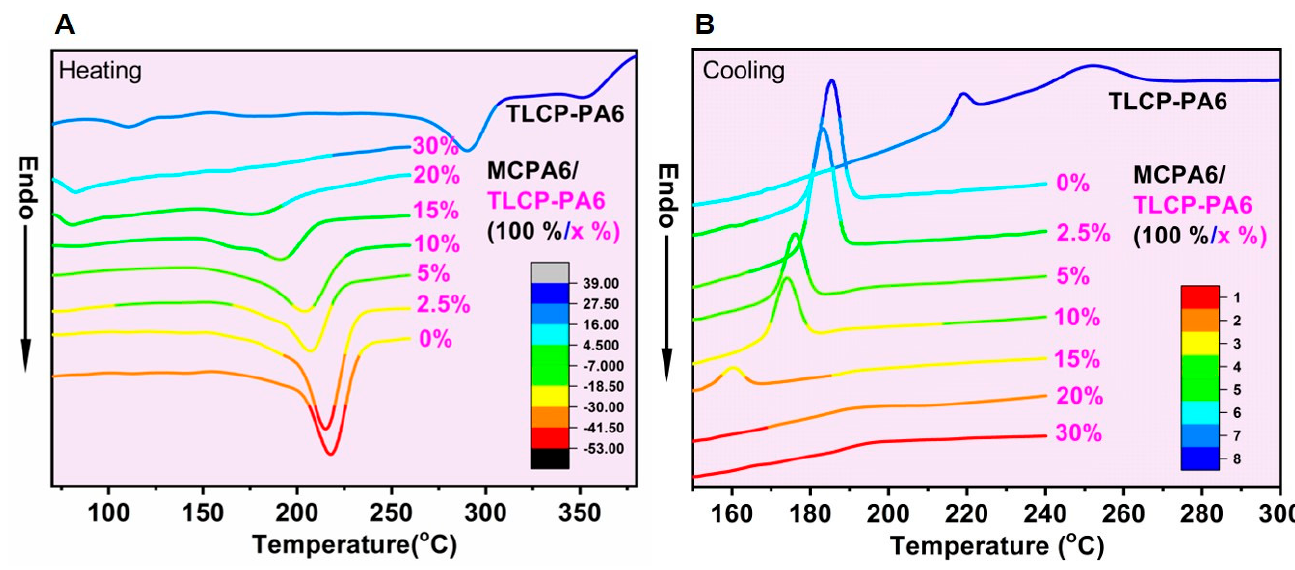
Figure 5. Thermograms of different MCPA6/TLCP-PA6 samples (100 wt. %/x wt. %), x wt. % = 0 ~ 30 wt. %, i.e., ( A ) heating curves and ( B ) cooling curves. Table 3. Melting and crystallization parameters of different samples derived from the DSC meas- urements.